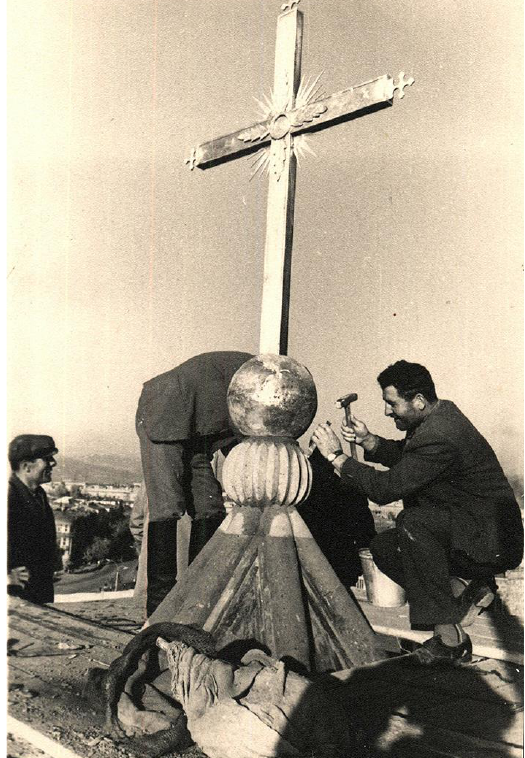
Figure 3. Rebuilding of the St. Savior Church bell tower,